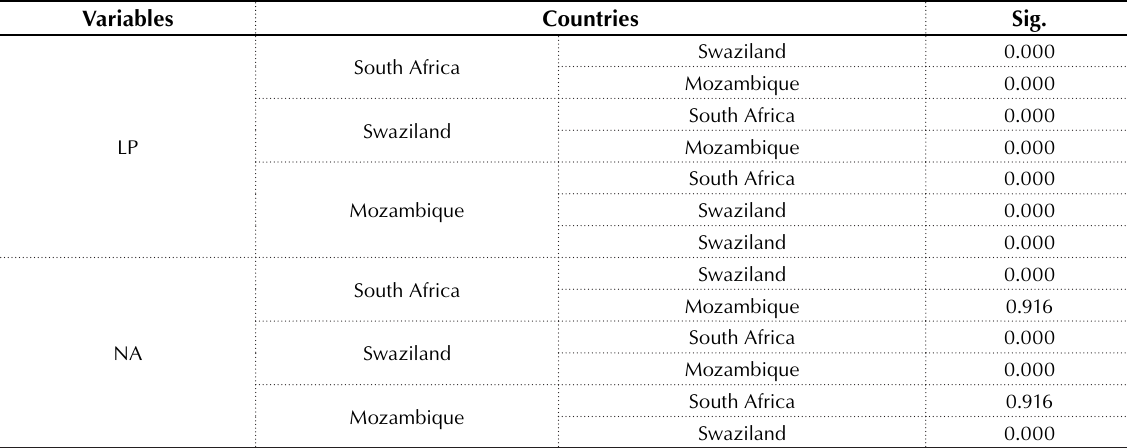
Table 5. Post-hoc tests for cross-country perceptions of the contributing roles of LP and NA to the coping ability of African immigrant